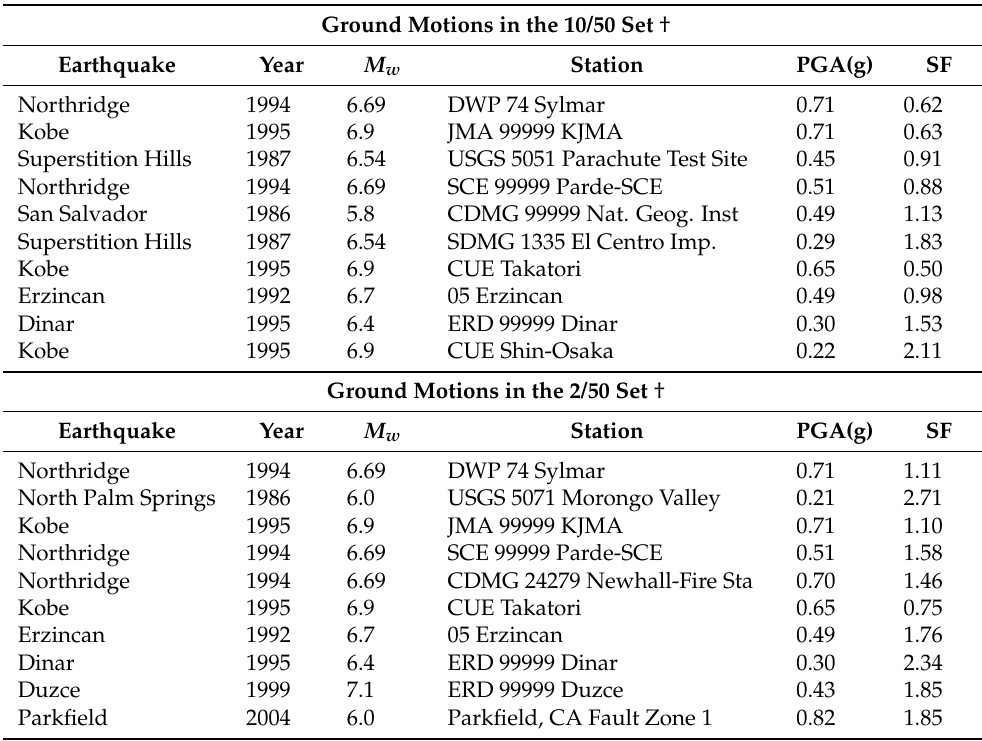
Table 2. Characteristics of Ground Motion Records used in the